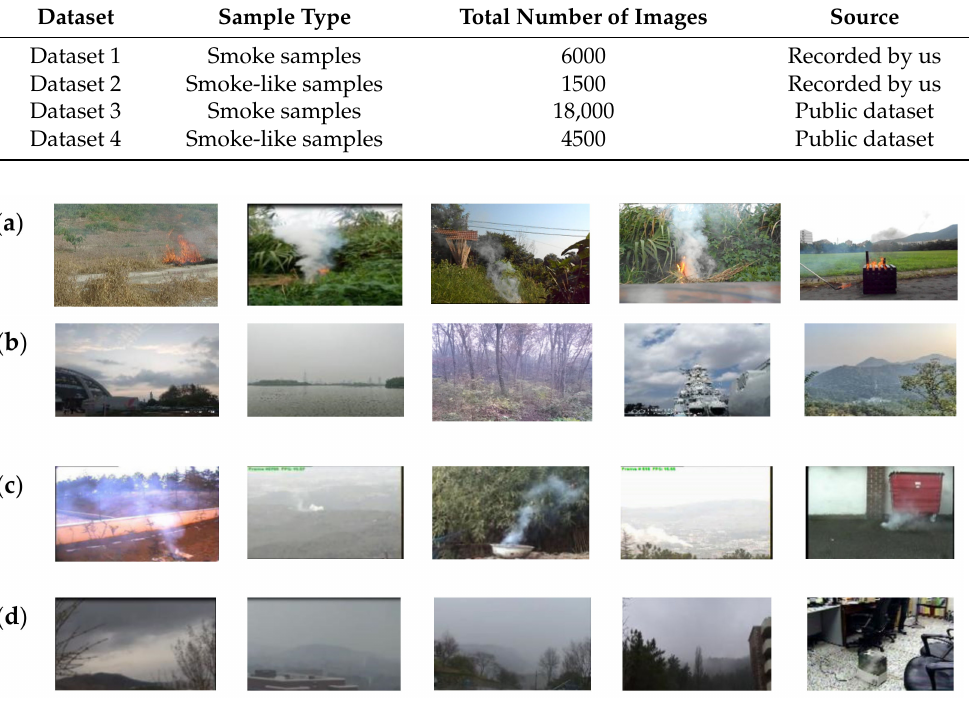
Figure 5. Several samples from the above four datasets. ( a ) smoke samples from Dataset 1; ( b ) smoke-like samples from Dataset 2; ( c ) moke samples from Dataset 3; ( d ) smoke-like samples from Dataset